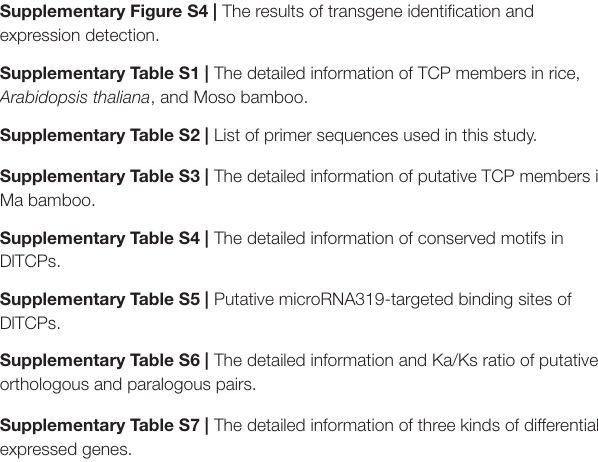
Supplementary Figure S2 | Distribution of Ka and Ks from paralogous ( Dl-Dl ) and orthologous ( Dl-Os , Dl-Pe ) gene pairs. Supplementary Figure S3 | GO annotation results of all differential genes and TCP members in the transcriptome. Supplementary Figure S4 | The results of transgene identification and expression detection.